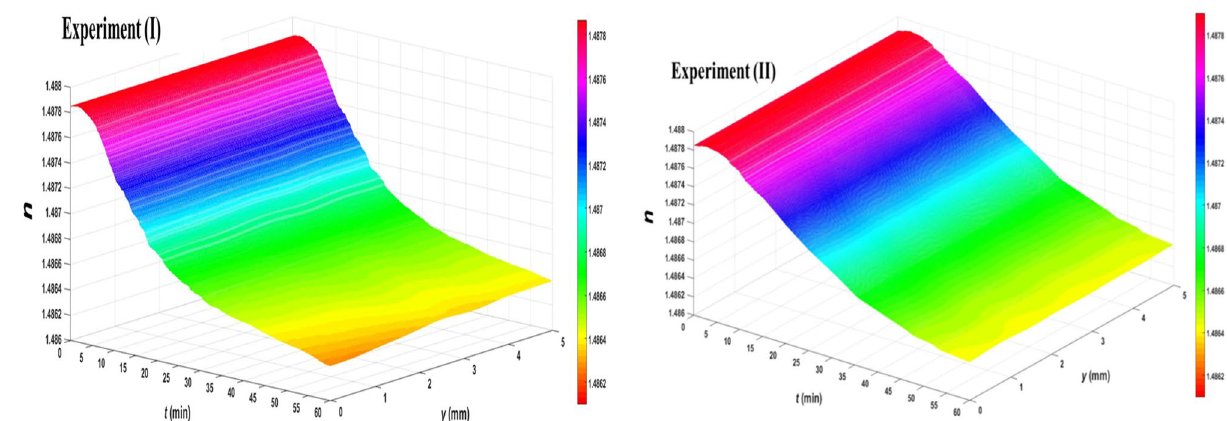
Figure 6. Persistent spatio-temporal refractive index profiles of UV 254 irradiated toluene for both